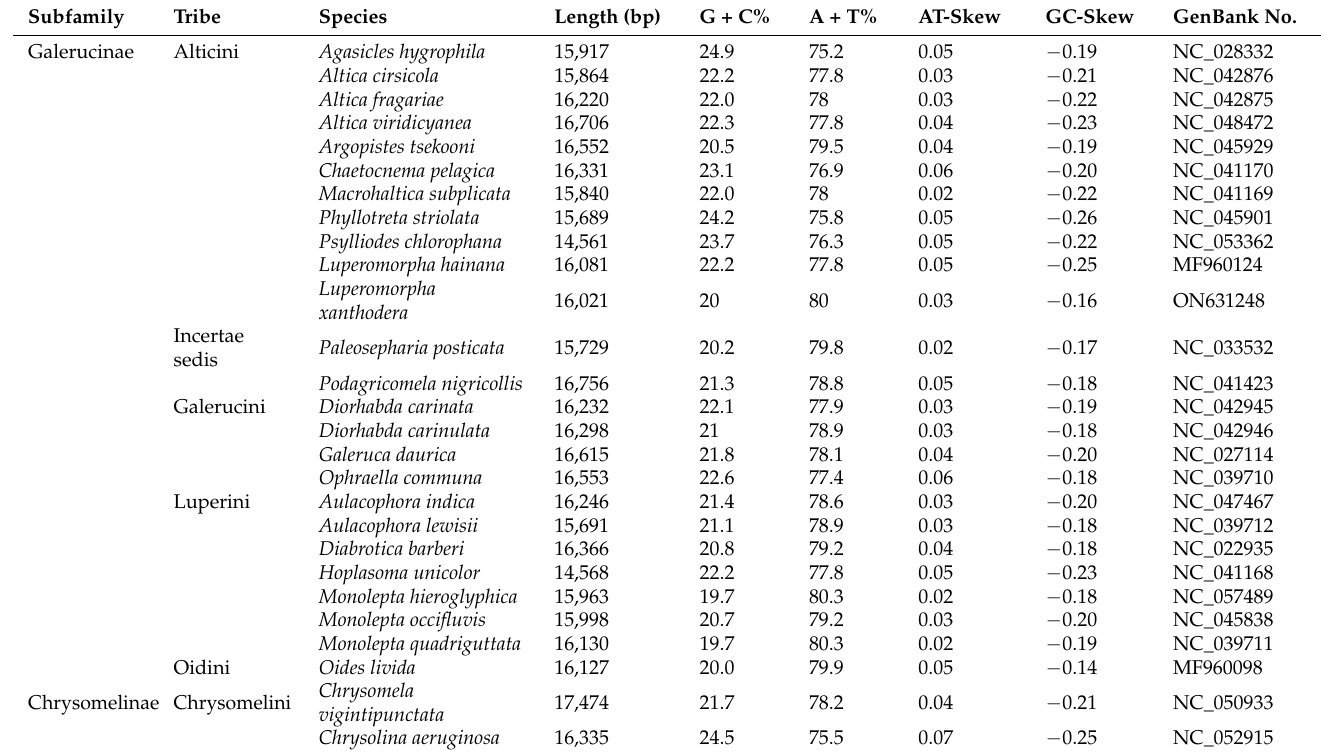
Table 1. Mitochondrial genomes were used for the phylogenetic analyses in this